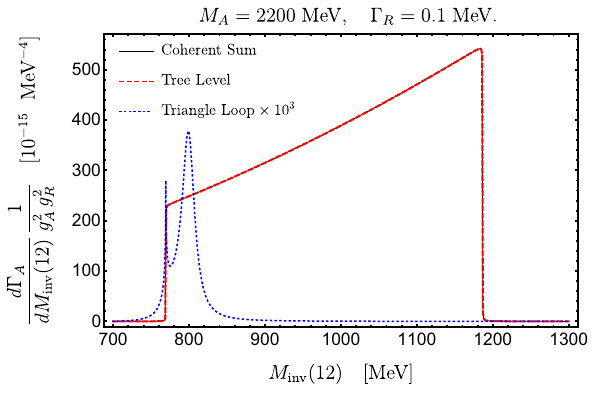
1 Fig. 10 d (cid:4) A as a function of M inv ( 12 ) with M A = dM inv ( 12 ) g 2 A g 2 R 2200 MeV and (cid:4) R = 0 . 1 MeV. The dashed and solid lines are indis- tinguishable in the figure